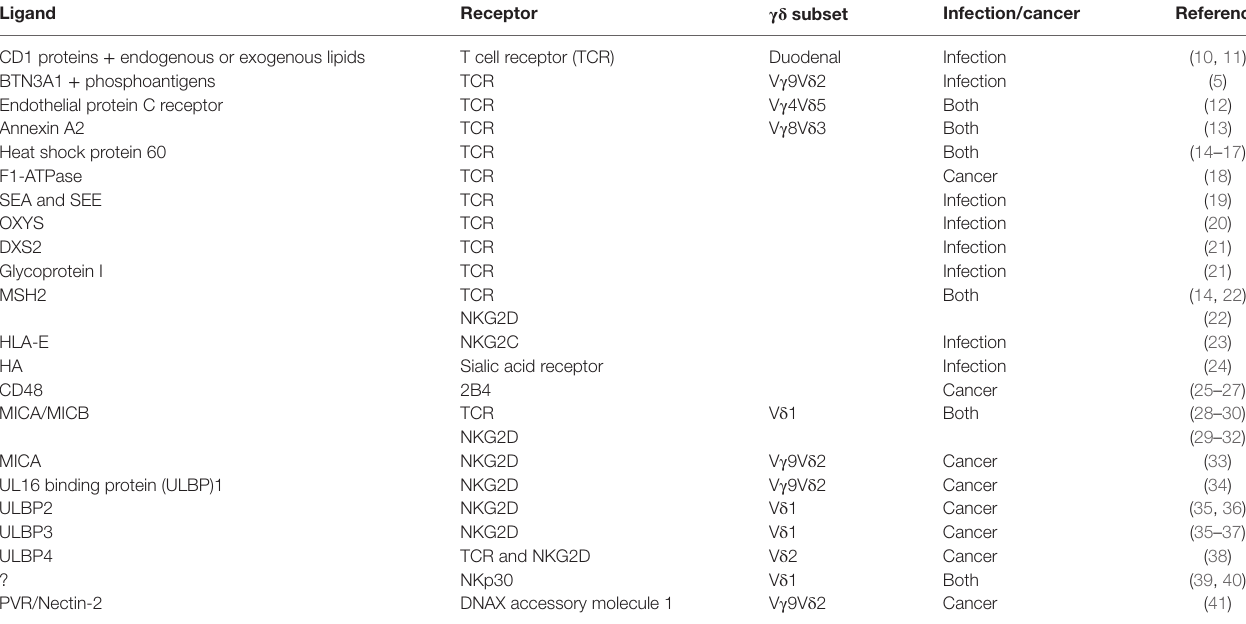
TabLe 1 | Tumor- or infected cell-associated ligands recognized by gamma-delta ( γδ ) T cells.